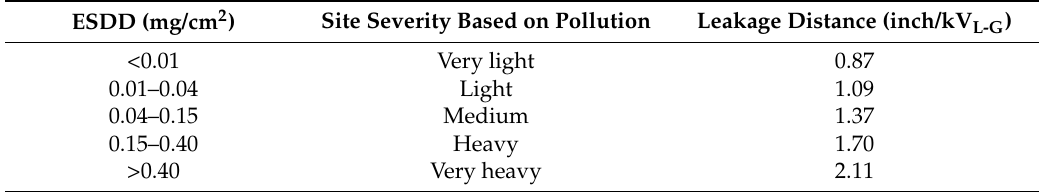
Table 4. Pollution severity based on the equivalent salt deposition density (ESDD) [38].